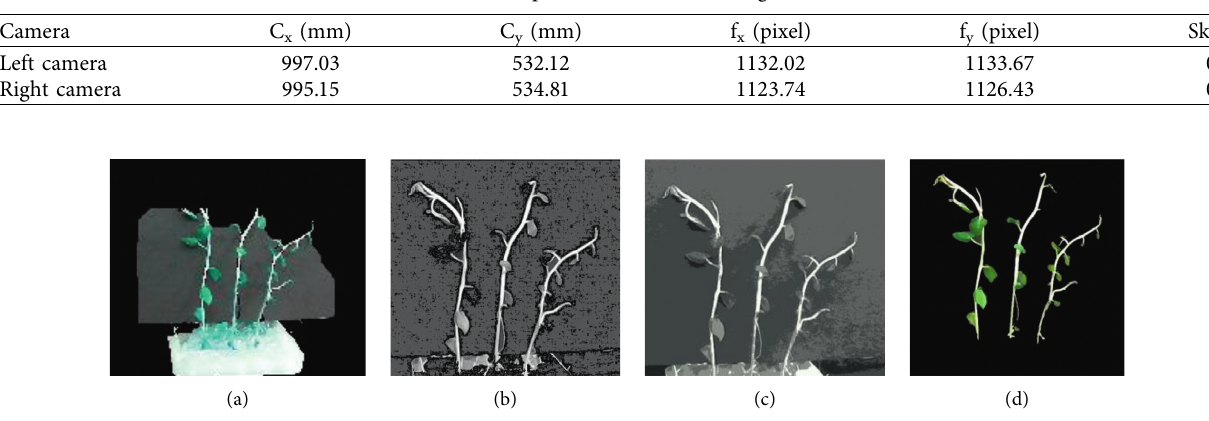
Table 2: Intrinsic parameters of left and right cameras.